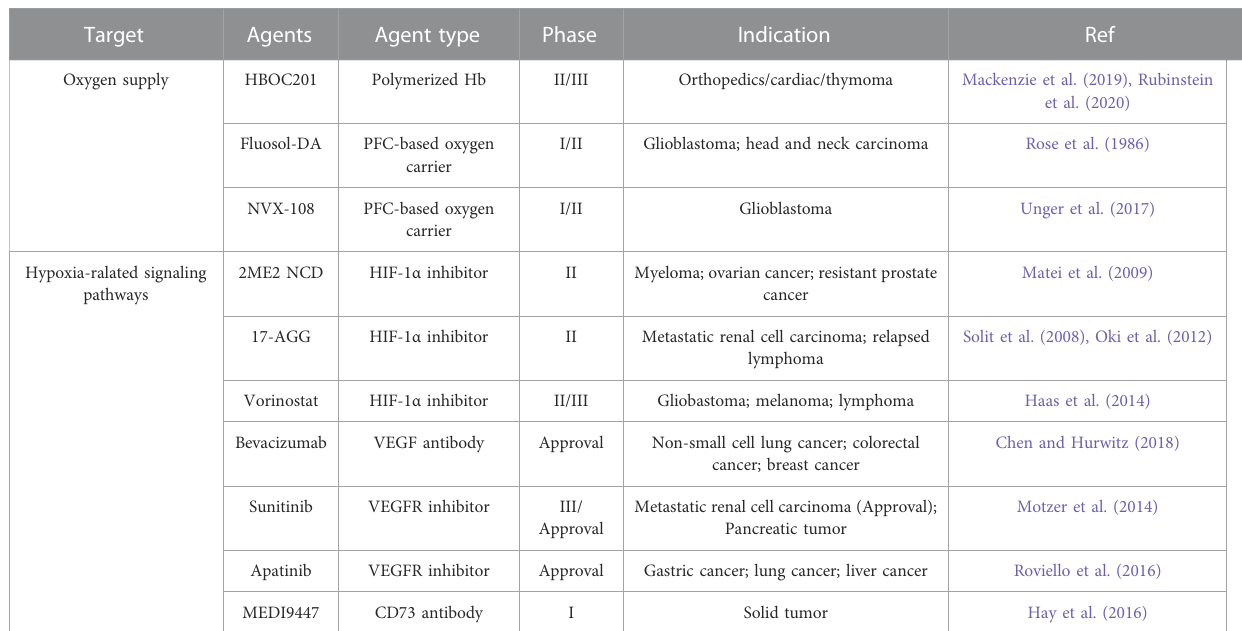
TABLE 3 Clinical trials of agents for hypoxia modulation in